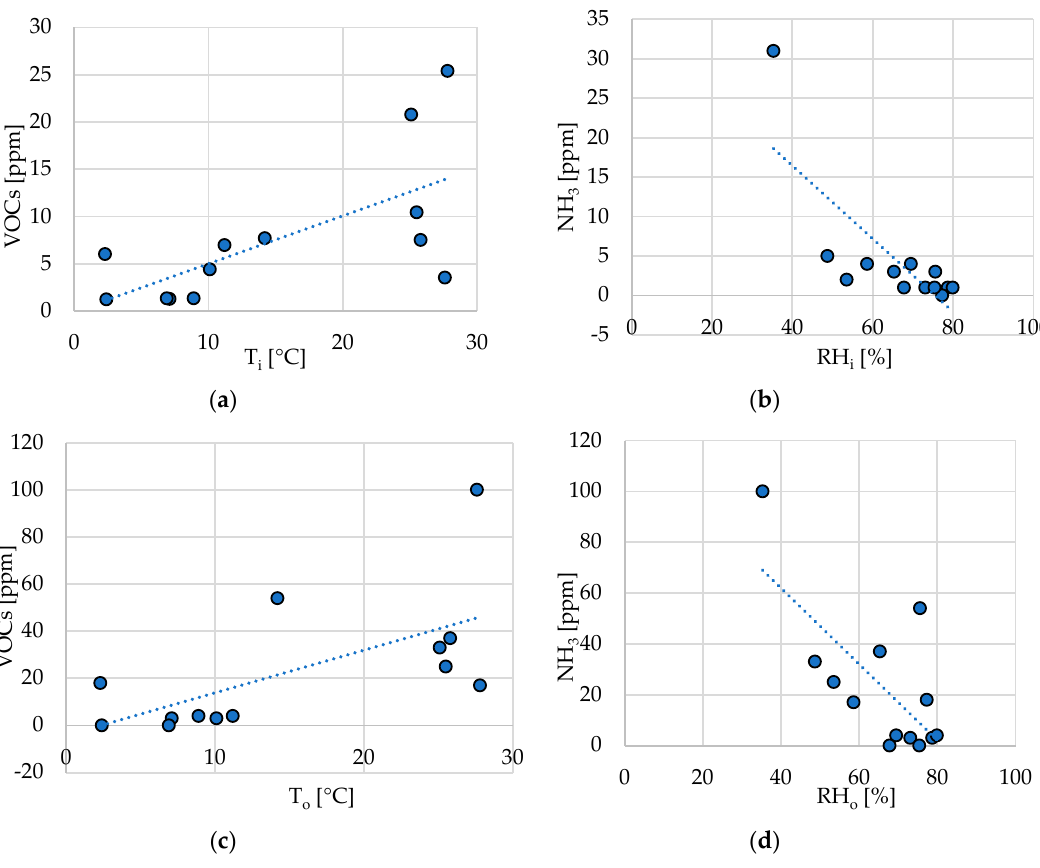
Figure 8. Correlation diagrams between odorant concentration in the fermentation preparation section of biogas plant B and measured microclimatic parameters, with regression lines: ( a ) fermentation fraction R 2 = 0.44, ( b ) fermentation fraction R 2 = 0.59, ( c ) wastewater tank R 2 = 0.39, ( d ) wastewater tank R 2 = 0.50.